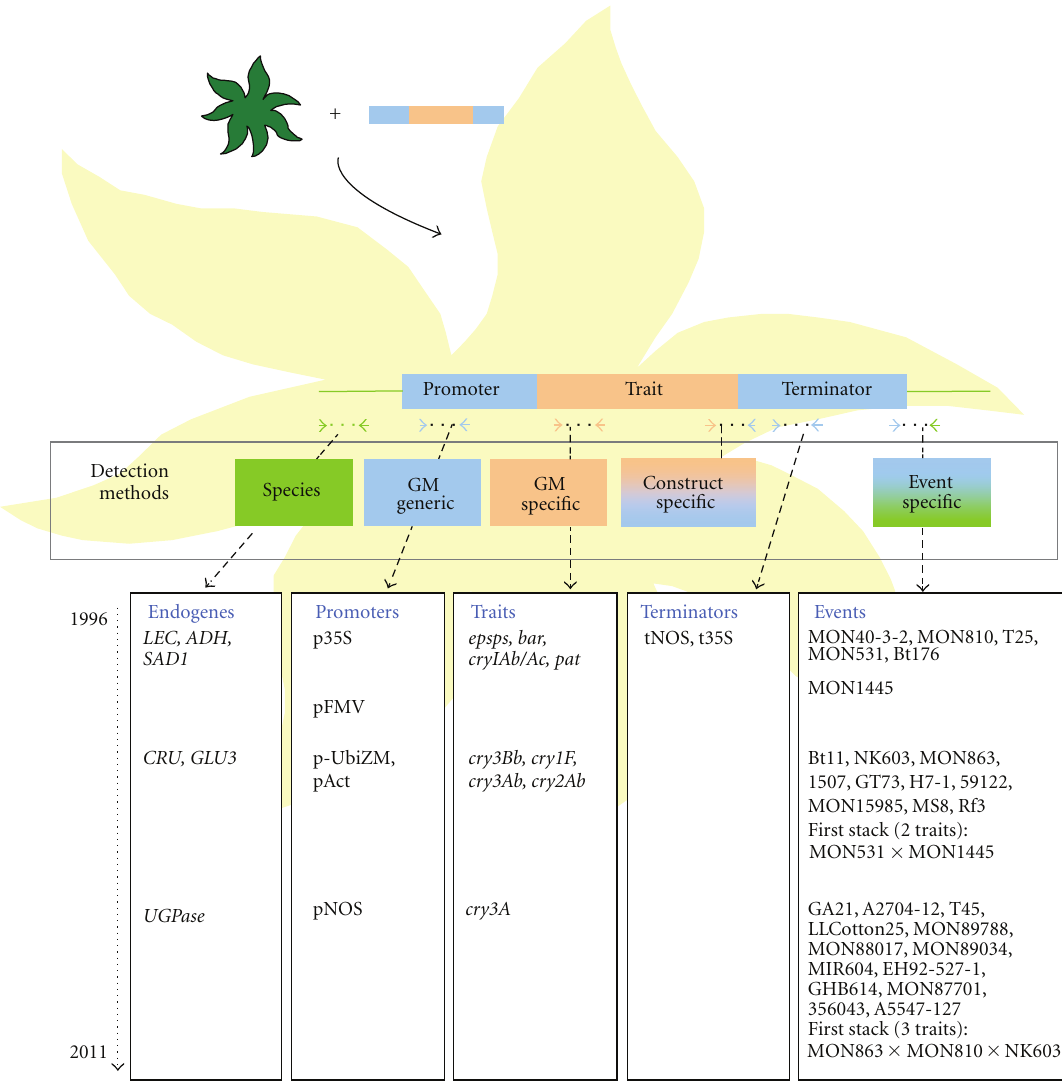
Figure 1: Evolution of the currently GM events authorised in the EU and their respective markers. This list is voluntarily not exhaustive but aims at giving the general trend in GMO evolution (see text and JRC Compendium [23] for details).